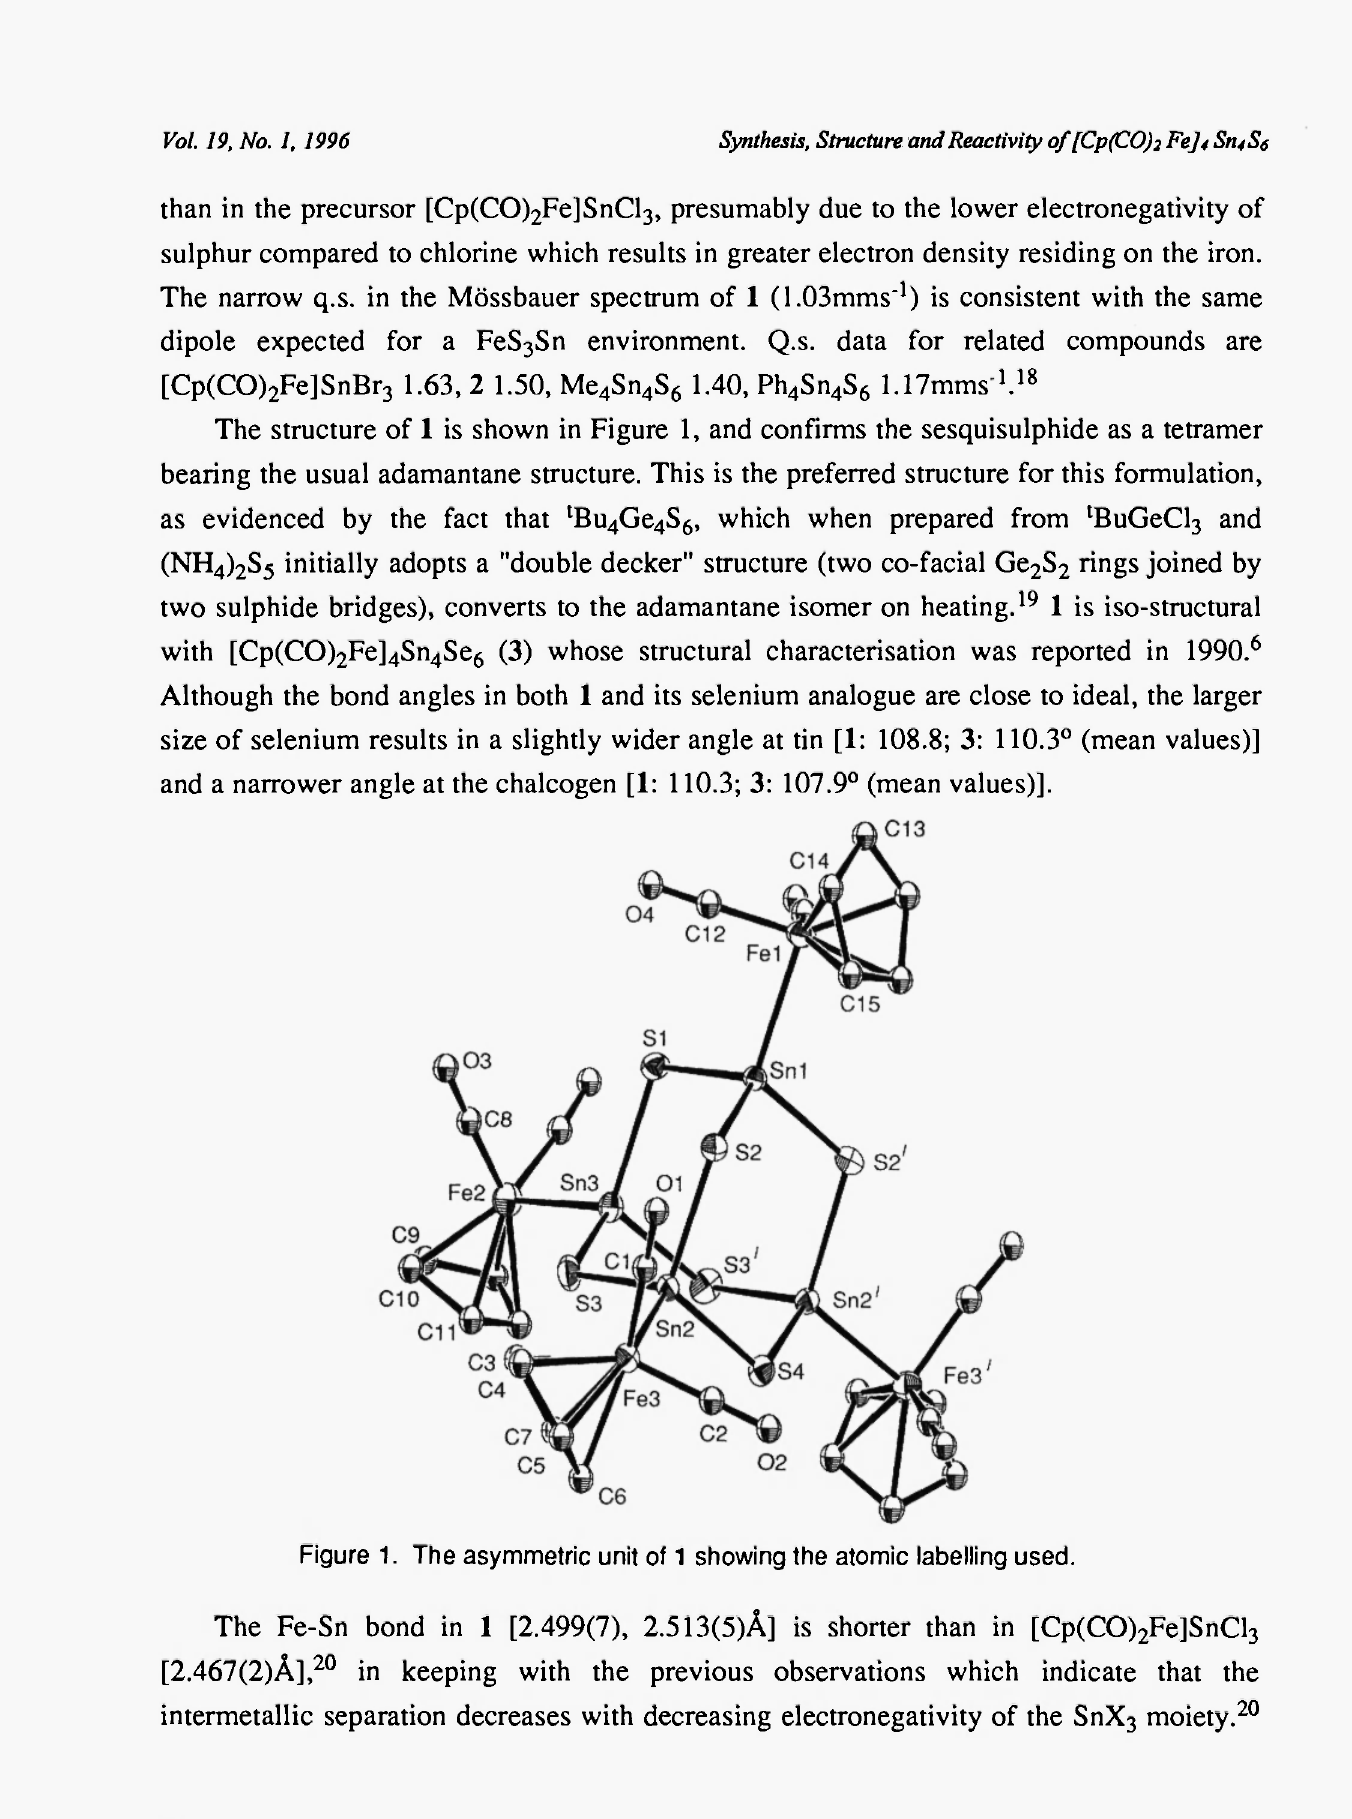
Figure 1. The asymmetric unit of 1 showing the atomic labelling